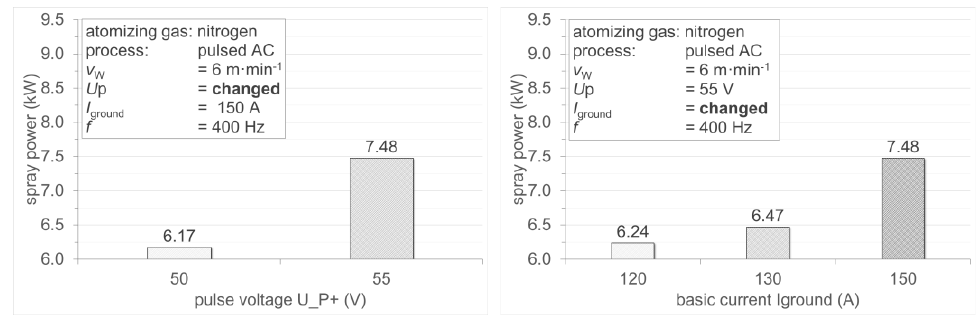
Figure 15. Comparison of the spray power as a function of the pulse voltage ( left ) and the base current ( right ) with pulsed alternating current.